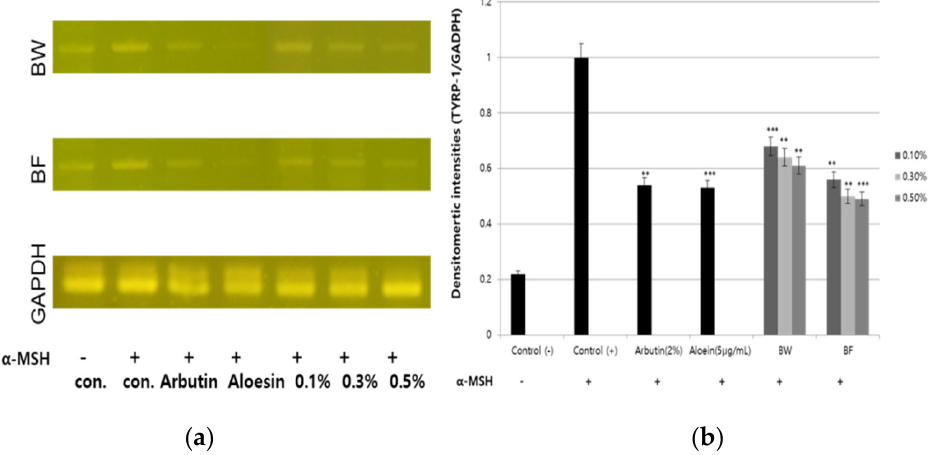
Figure 7. Downregulation of mRNA expression of TYRP-1 from α -MSH treated B16F10 cells ( a ) and relative densitometric intensities corresponding to each PCR band normalized with a house keeping gene, GAPDH ( b ) in treating various concentrations of two extracts of aloe skin leaf, and 5 µ g/mL aloesin and 2% arbutin as positive controls. BW: Water extract of aloe skin leaf at 100 ◦ C for 24 h. BF: Fermented extract of aloe skin leaf fermented with L. plantarum BN41 at 37 ◦ C for 3 days and further extracted by an ultrasound generator at 20 kHz for 4 h. The mean values ± SD for separate triplicate experiments are shown, and error bars indicate the SD. The significance of the difference was set to ** p < 0.01 and *** p < 0.001 compared with the control (+).